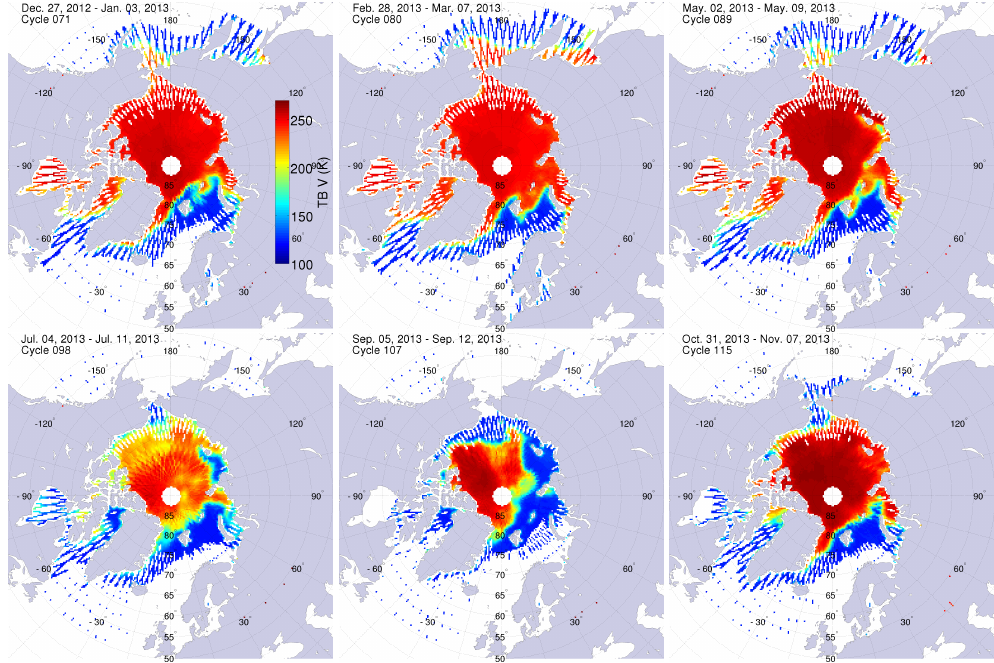
Fig. 9. Maps of TB (radiometer 3) at V polarization over the NH sea ice every two months in 2013. Grid cells where the land fraction was more than 0.25 were masked.